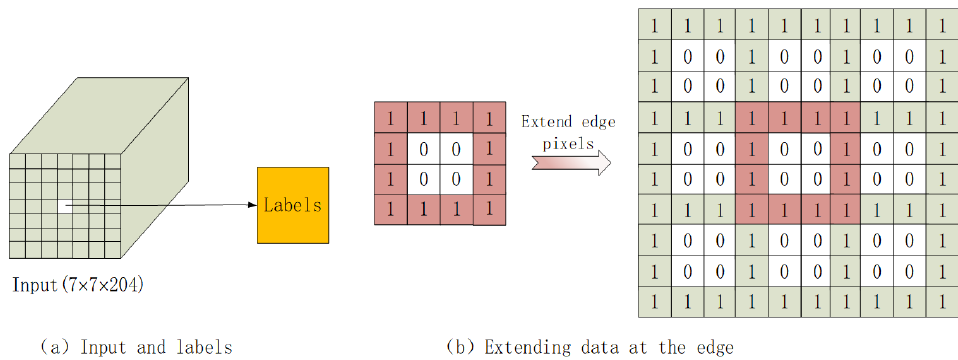
Figure 2. Label category selection for hyperspectral